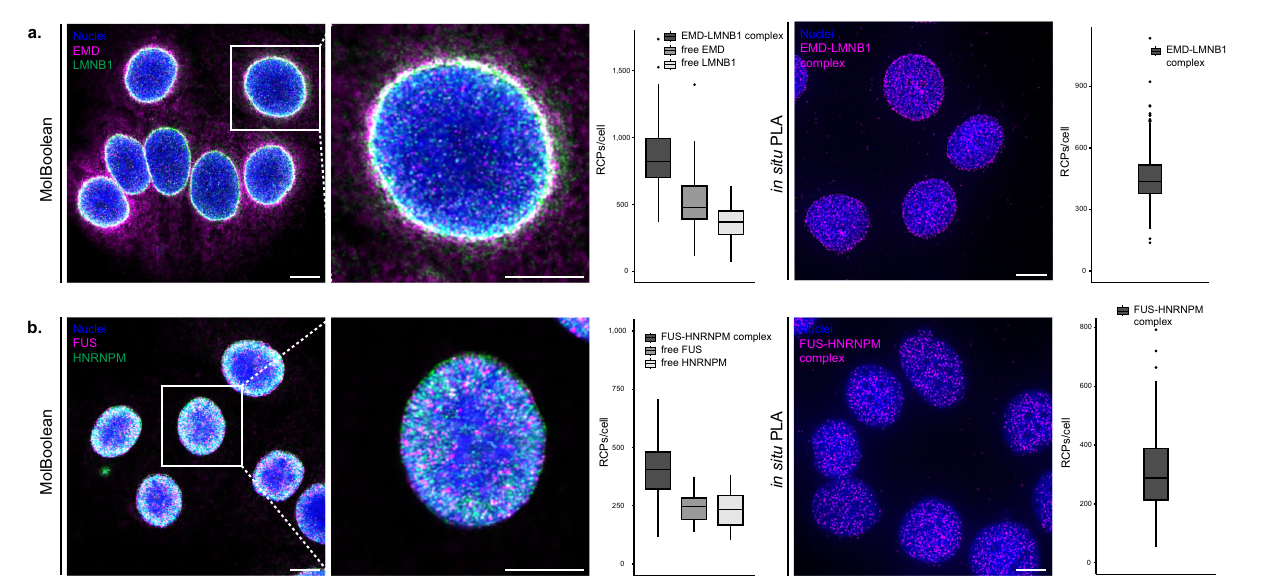
Fig. 6 | MolBoolean and in situ PLA staining of nuclear proteins in MCF7 cells. a EMD and LMNB1 co-stain. MolBoolean signals are shown for EMD (magenta), LMNB1 (green), EMD-LMNB1 complex (white) and nuclei (blue). In situ PLA signals for EMD-LMNB1 complex are shown in magenta and nuclei in blue. b FUS and HNRNPM co-stain. MolBoolean signals are shown for FUS in magenta, HNRNPM (green), FUS-HNRNPM complex (white) and nuclei (blue). In situ PLA signals for FUS-HNRNPM complex are shown in magenta and nuclei in blue. White frames